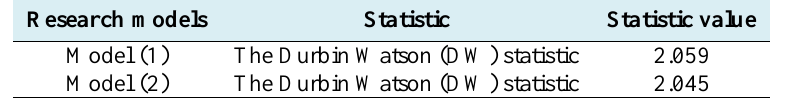
Table 6 . The results of testing the absence of residual autocorrelation in the TSE